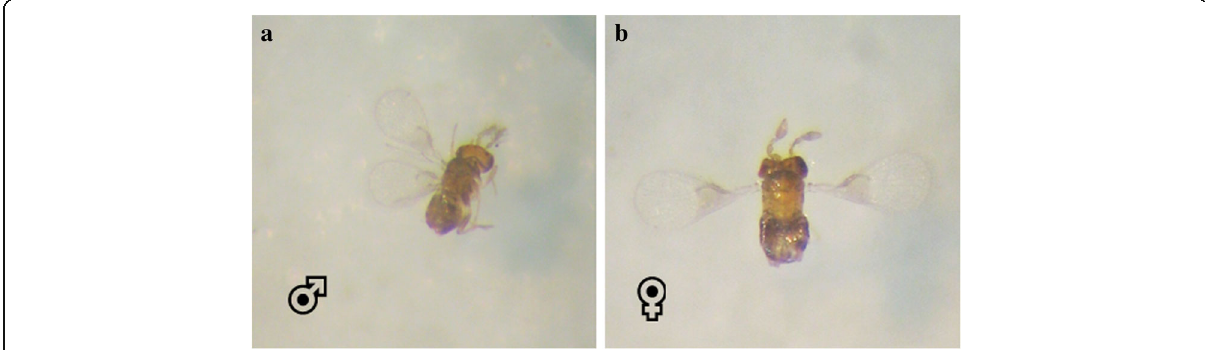
Fig. 1 a , b Male and female Trichogramma strain TNV ( x =